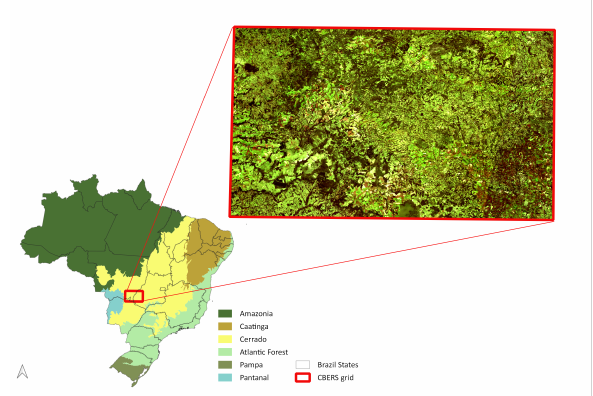
Figure 3. Left: study area in relation to Brazil and its biomes. Right: CBERS-4/WFI image from June, 2018 of the study area (RGB - 14/13/15 bands).